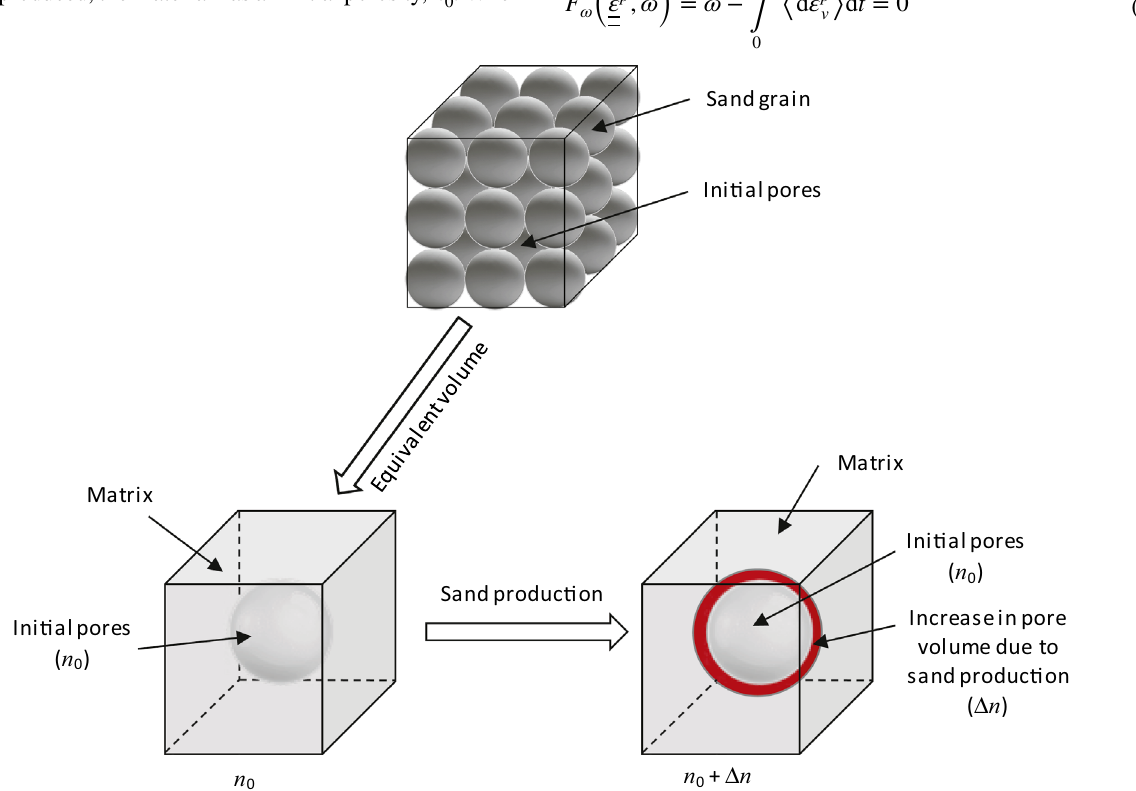
Fig. 1 Illustration of increase in porosity as a result of sand